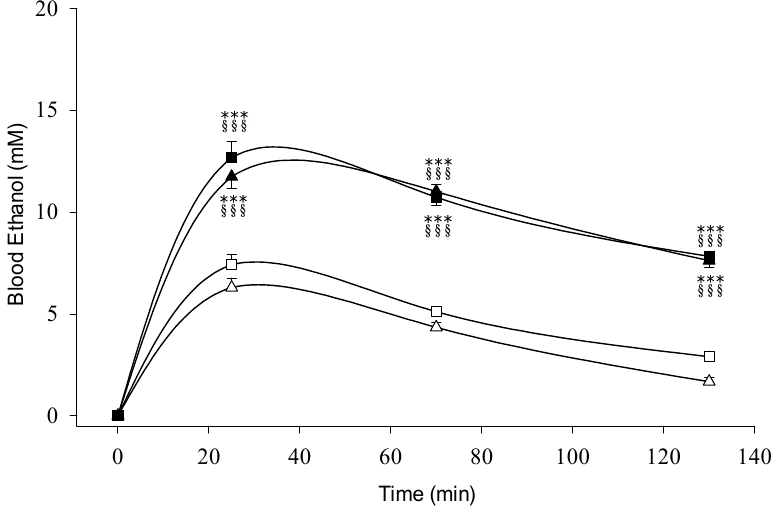
Figure 1. Blood ethanol concentrations of nonalcoholic subjects with different ALDH2 allelotypes following different doses of ethanol (0.3 g/kg body weight or 0.5 g/kg). All subjects are ADH1B*2/*2 homozygote. The study groups are denoted as △ , ALDH2*1/*1 with 0.3 g/kg ethanol ( n = 23); ▲ , ALDH2*1/*1 with 0.5 g/kg ethanol ( n = 21); □ , ALDH2*1/*2 with 0.3 g/kg ethanol ( n = 27); ■ , ALDH2*1/*2 with 0.5 g/kg ethanol ( n = 22). Vertical bars (for clarity only the upper or lower portion shown) represent standard errors of the mean. Statistical differences between groups at the corresponding time points was evaluated by ANOVA. *** p < 0.001 vs. ALDH2*1/*1 with 0.3 g/kg ethanol; §§§ p < 0.001 vs. ALDH2*1/*2 with 0.3 g/kg ethanol.